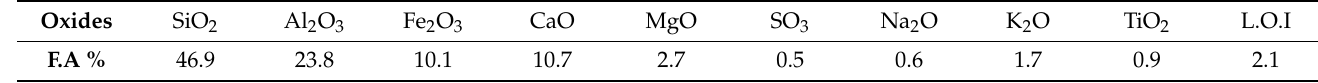
Table 1. Fly ash chemical composition.